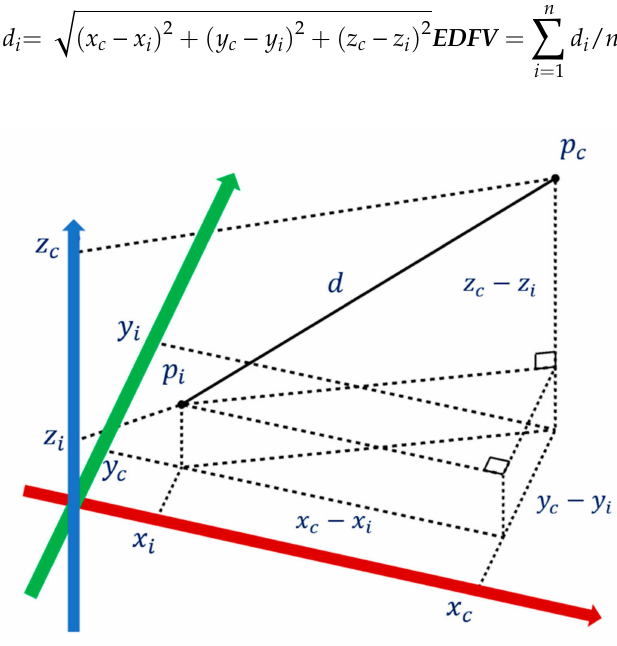
Figure 9. The schematic diagram of 3D Euclidean